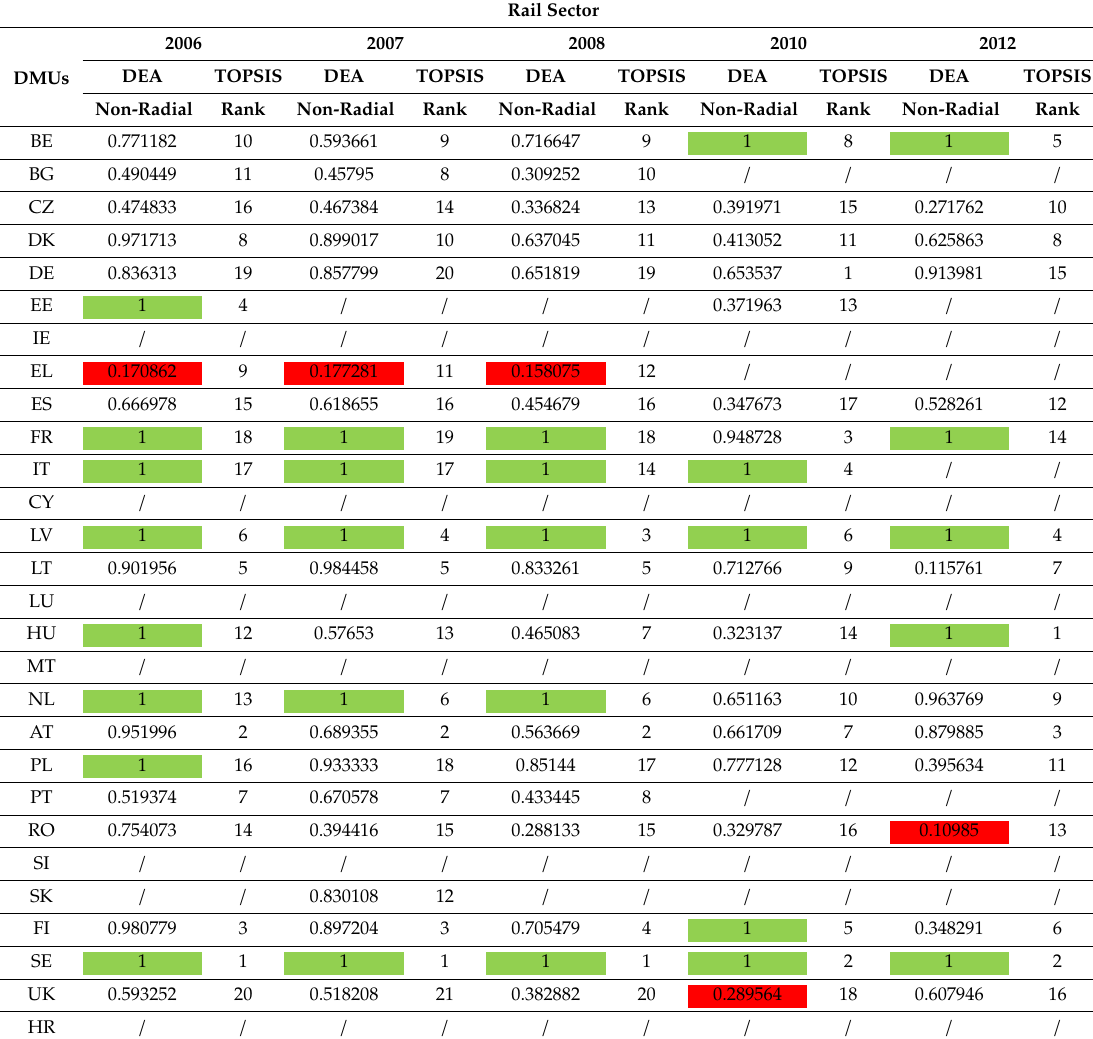
Green color: the best EEEI . Red color: the least EEEI